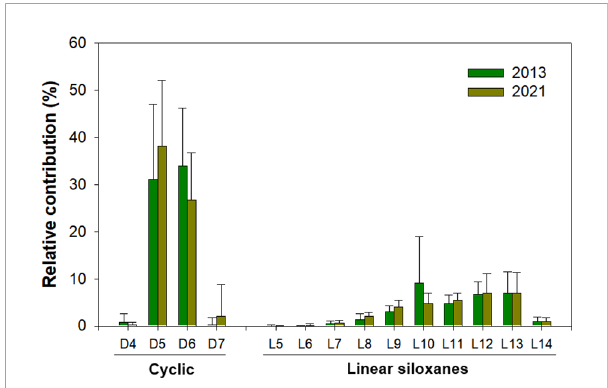
FIGURE 5 Compositional pro fi les of individual siloxanes in sediment from Masan and Haengam Bays, offshore, and the submarine outfall of a wastewater treatment plant collected between 2013 and